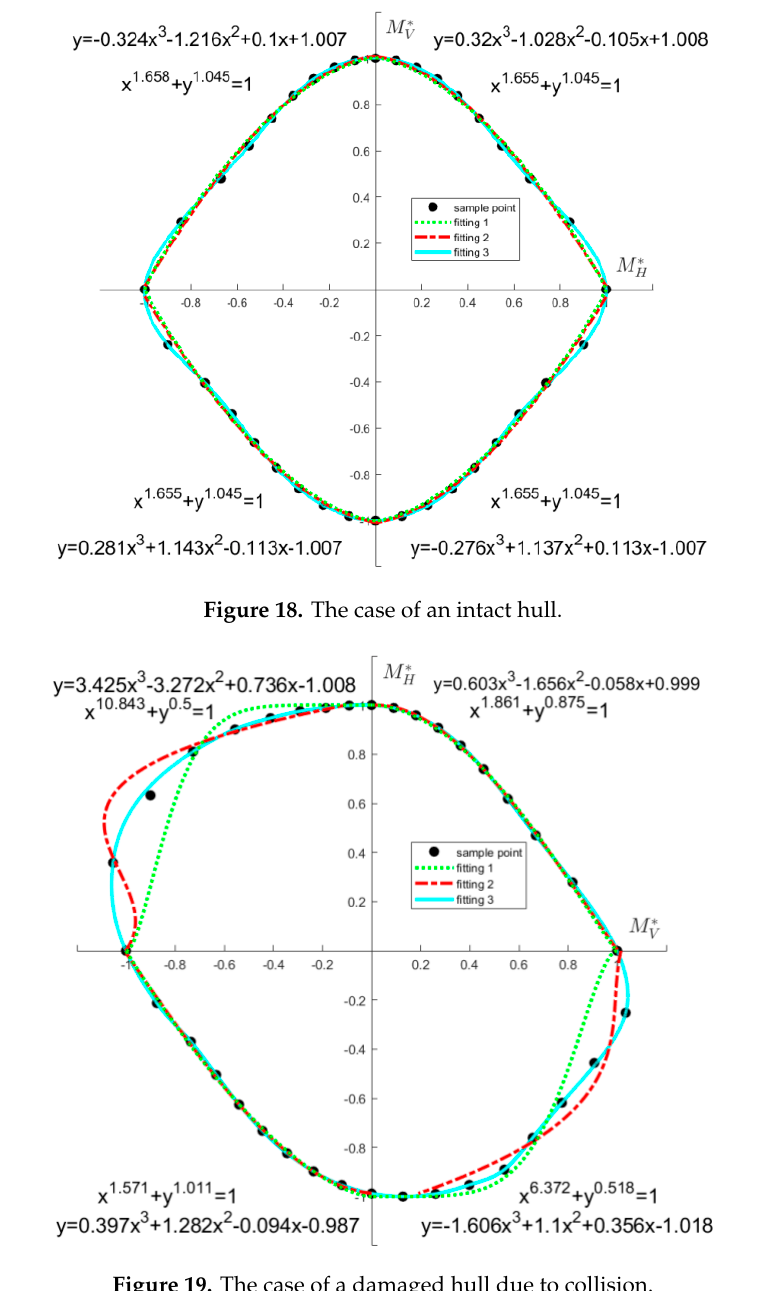
Figure 19. The case of a damaged hull due to collision.